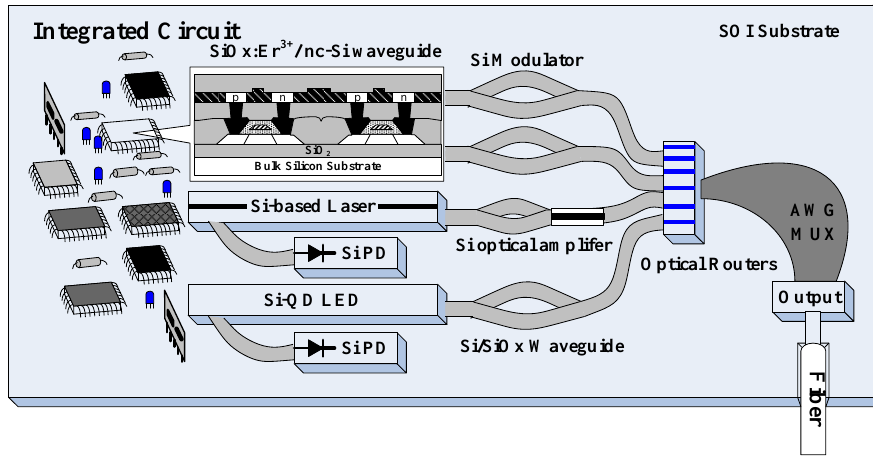
Figure 1. Schematic diagram of all-Si based photonic integrated circuit.